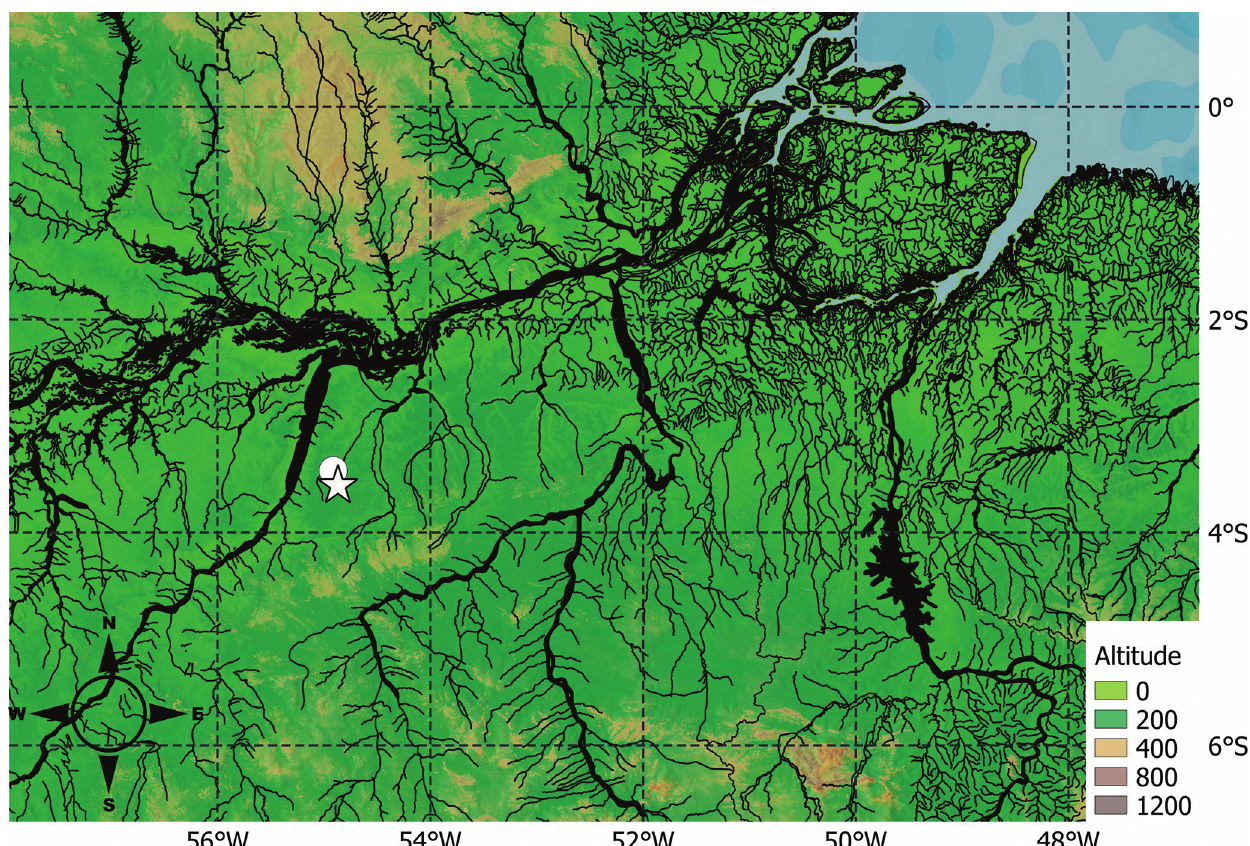
Fig. 4 . Collecting localities of Curculionichthys hera in the rio Curuá-Una basin, on road BR-163 between Belterra and Rurópolis, Belterra, Pará, Brazil. Star represents type-locality.